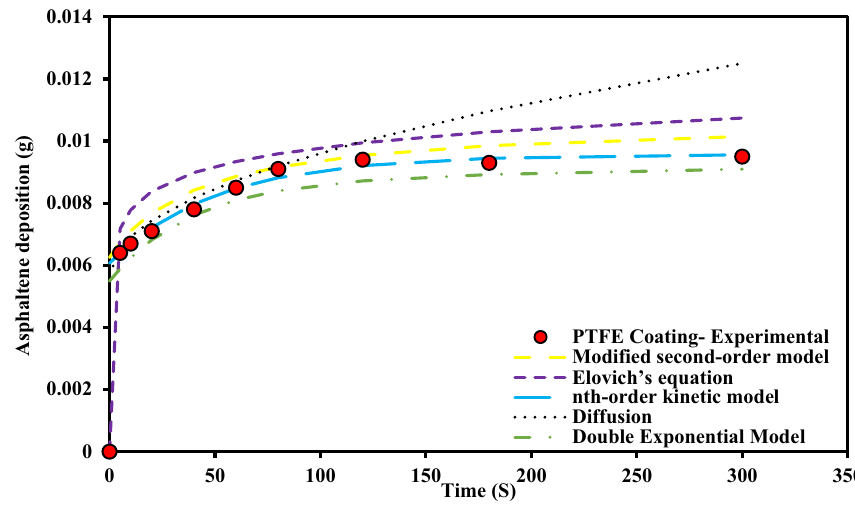
Figure 14. Comparison of experimental data and deposition kinetic models for PTFE coating electrode at 2000 ppm concentration in static state.